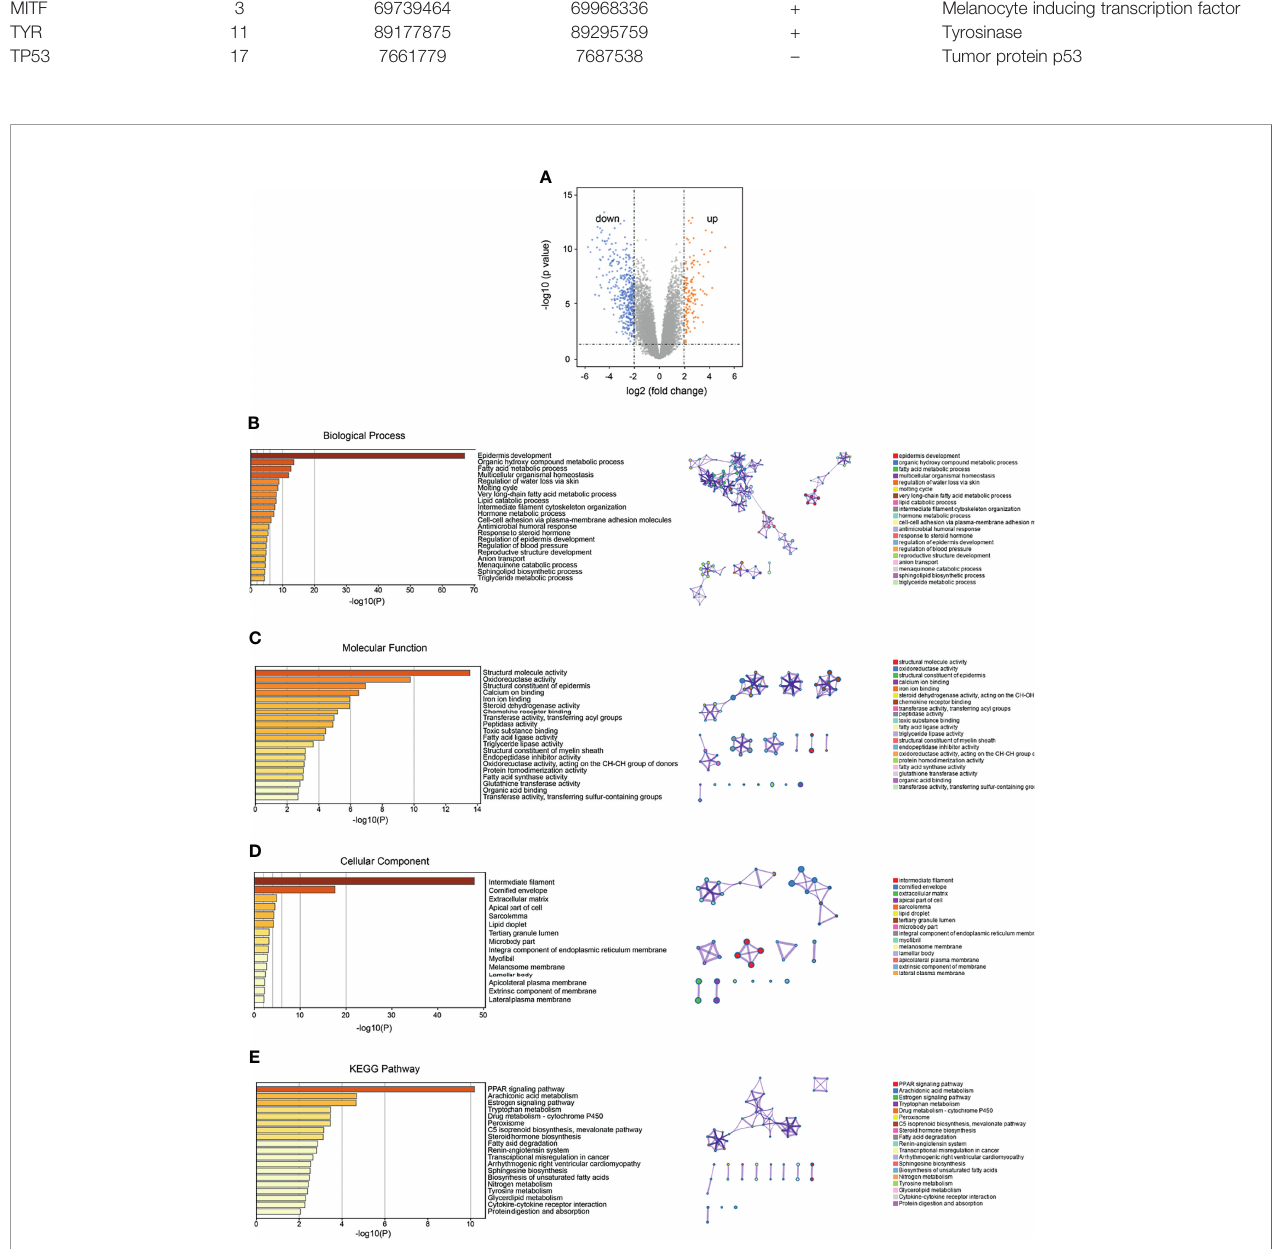
FIGURE 3 | Identi fi cation and functional enrichment analysis of SKCM DEGs. (A) Volcano plot of the identi fi ed DEGs (orange and blue dots represent upregulated and downregulated genes, respectively). (B) Functional enrichment analysis of GO (gene ontology) and biological process (BP) of DEGs. (C) Enrichment analysis of GO molecular function (MF) of DEGs. (D) Functional enrichment analysis of GO cell components (CC) of DEGs. (E) Functional enrichment analysis of KEGG (Kyoto Encyclopedia of Genes and Genomes) pathway in